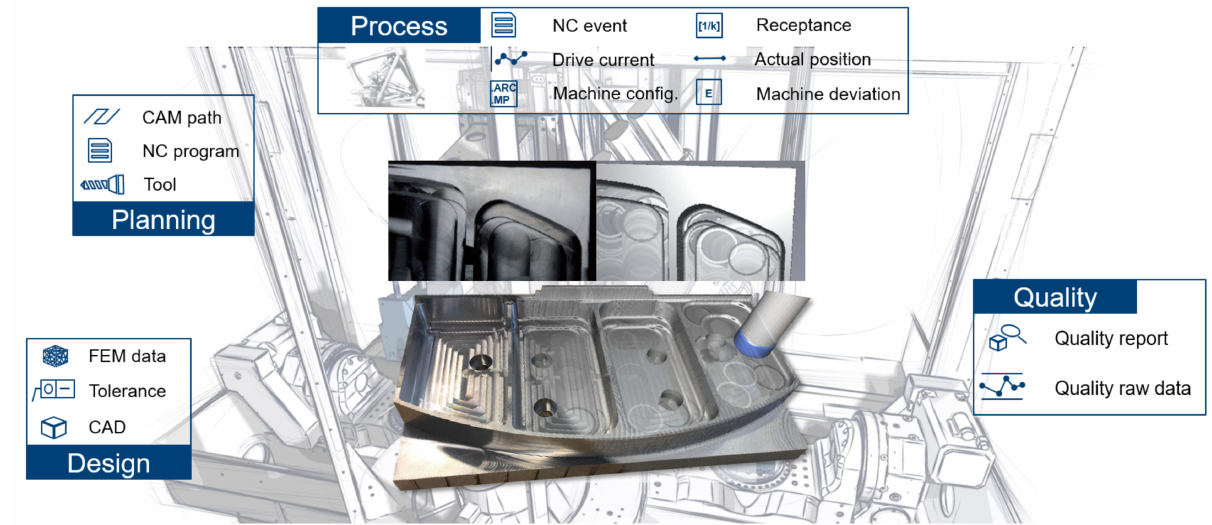
Figure 5. An illustration of DT in manufacturing: workpiece quality monitor [26]. © WZL—RWTH